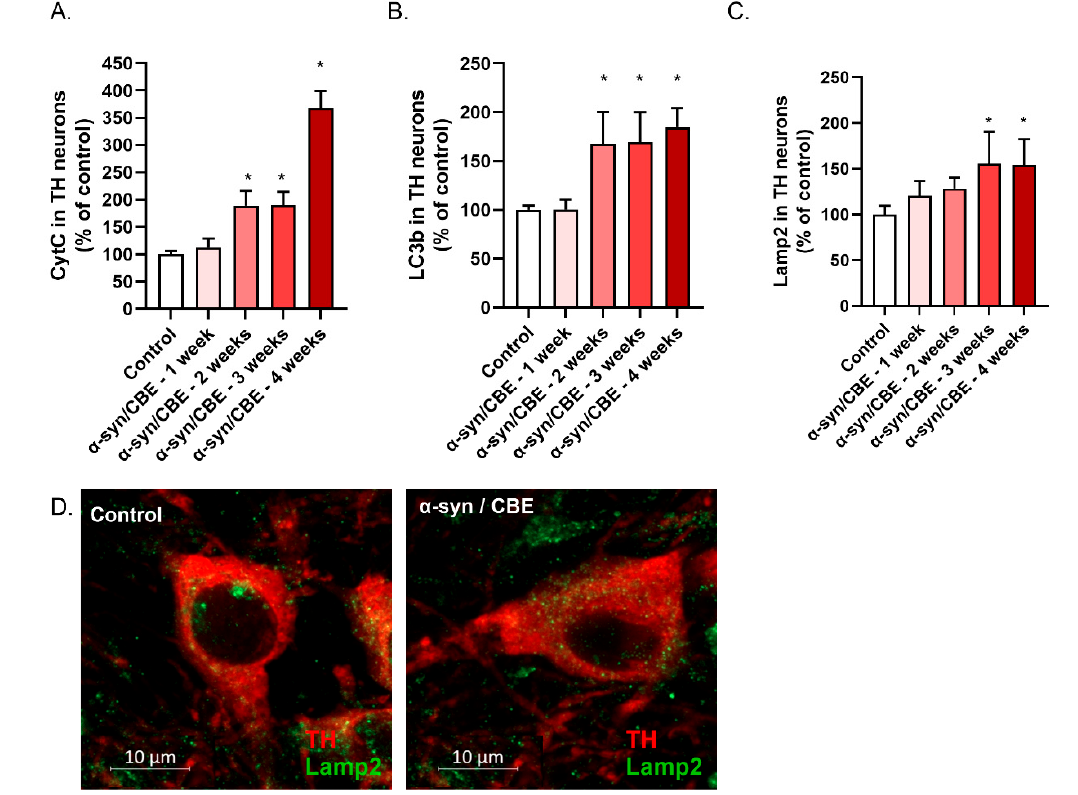
Figure 5. α -syn/CBE mice present with progressive mitochondrial stress and autolysosomal stress in the substantia nigra . Total area of CytC (control = 1150 μ m 2 ± 10) ( A ), as well as area of LC3b (control = 7 μ m 2 ± 9) ( B ) and Lamp2 (control = 2027 μ m 2 ± 13) ( C ) in TH(+) after stereotaxic injection of α -syn were studied. ( D ) Representative pictures of TH(+) control (left panel) and α -syn (right panel) for Lamp2 (green). All values are expressed as mean ± SEM; *, p < 0.05 with one-way ANOVA followed by Fisher’s LSD